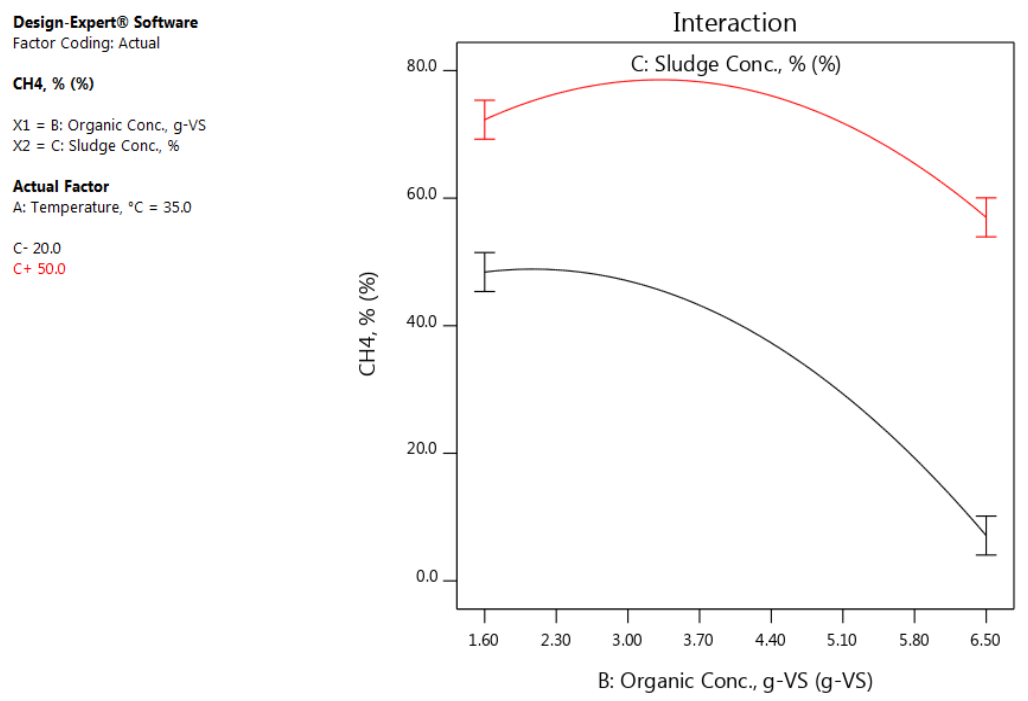
Figure 8. The interaction of the BC on the CH 4 % in an interaction plot.